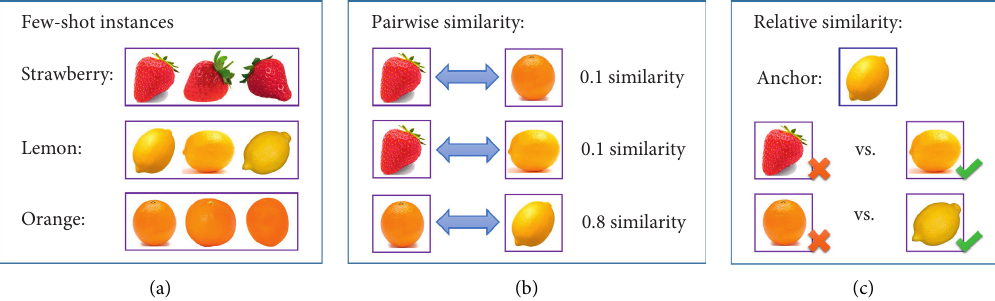
Figure 1: An example that shows the advantage of relative similarity. Left: nine objects from three different classes. The lemons and oranges are similar in appearance. Middle: a pairwise similarity-based model may be confused by a pair of objects from the lemon and orange classes. Right: if a model learns relative similarity between objects, it may not be confused since the anchor object (in the blue box) is relatively similar to the lemon compared to the orange.